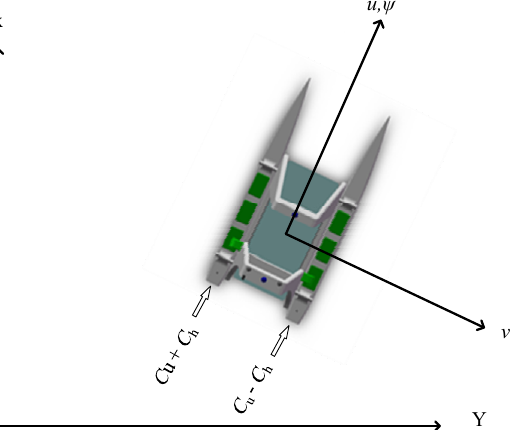
Figure 6. The diagram for speed and course regulation of the USV.